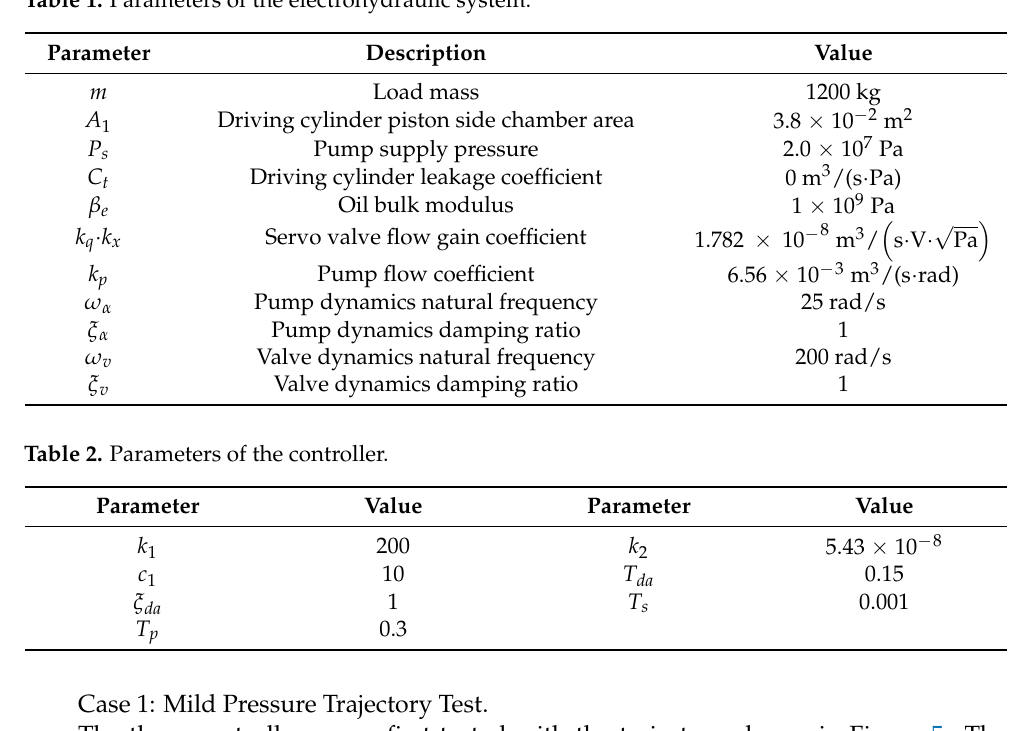
Table 1. Parameters of the electrohydraulic system.